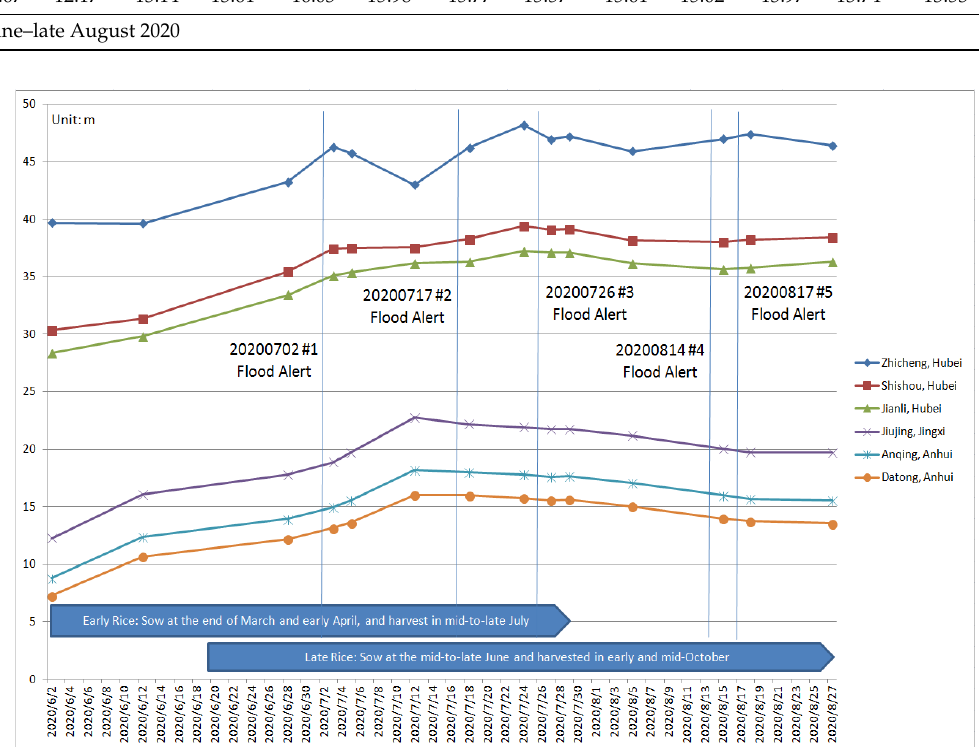
Figure 2. Water level, five flood alerts and rice sowing schedule for middle reaches of the Yangtze River.